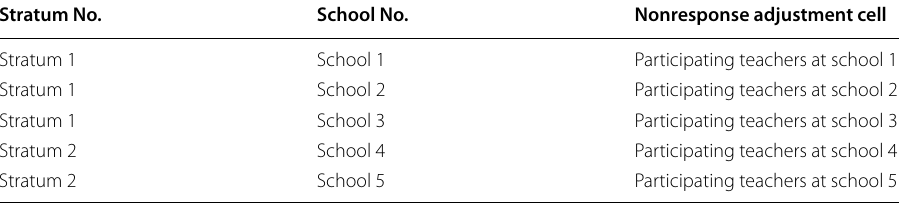
Table 4 Teacher nonresponse adjustment (WGTADJ2T) in international database ICILS 2018 Stratum